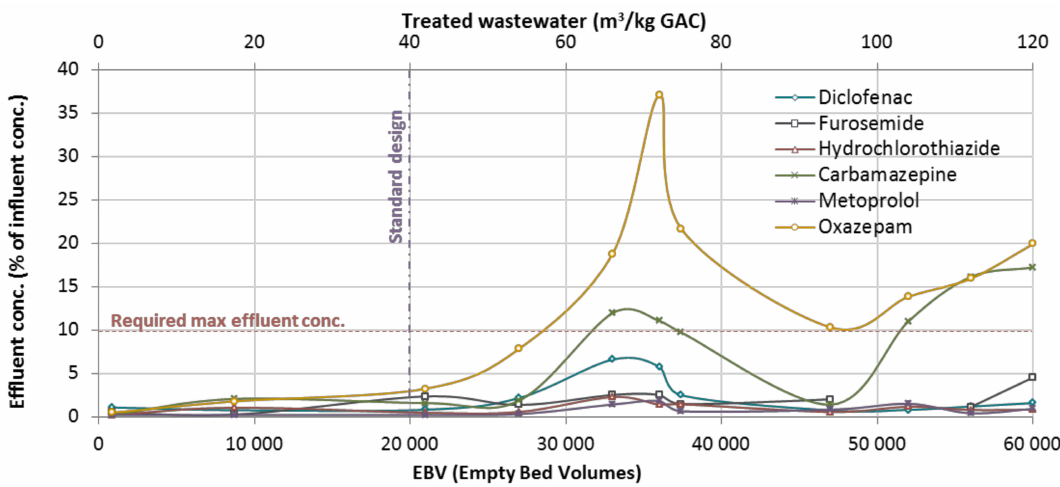
Figure 2. Average reduction of various pharmaceuticals during the whole project